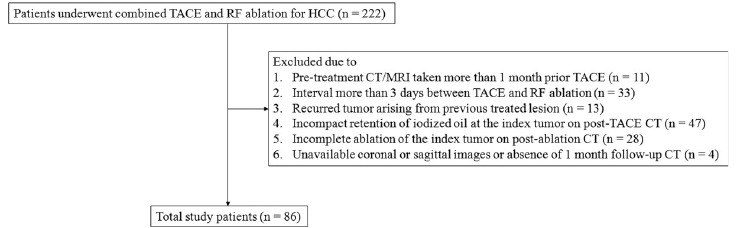
Fig 1. Flow chart of patient selection. TACE = transcatheter arterial chemoembolization, RF = radiofrequency, HCC = hepatocellular carcinoma.